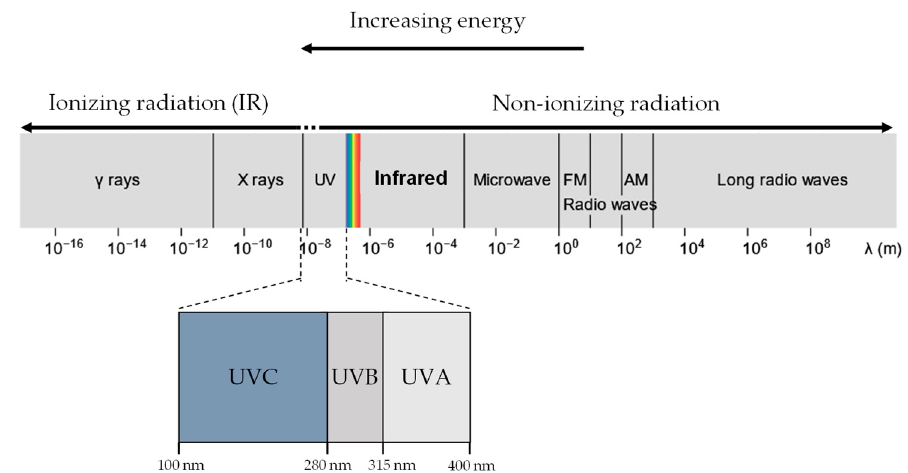
Figure 1. UVR, X-rays and gamma rays all lie in the electromagnetic spectrum. UVR (UV-A and UV-B) lie at a slightly higher energy range compared to visible light and are generally considered non-ionising. In contrast, X-rays and gamma rays have much higher energy than UVR and are considered ionising